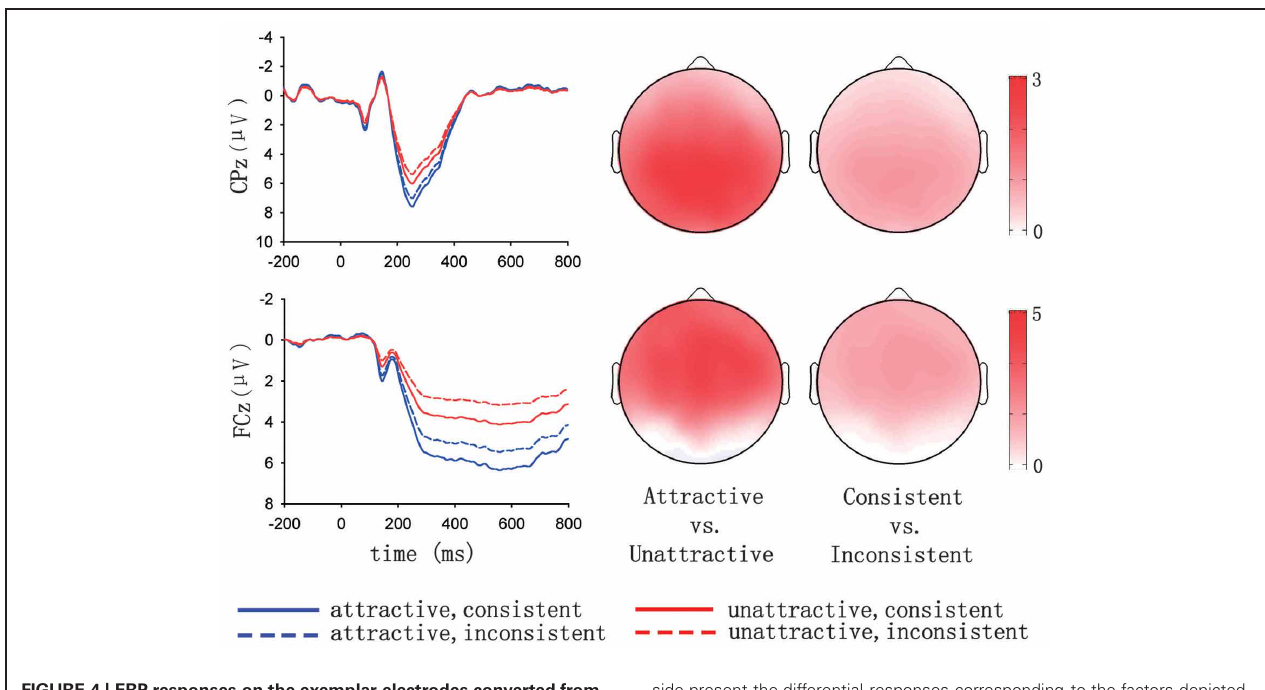
FIGURE 4 | ERP responses on the exemplar electrodes converted from factor scores in the spatiotemporal PCA and depicted as a function of attractiveness and feedback consistency. Topographic maps on the right